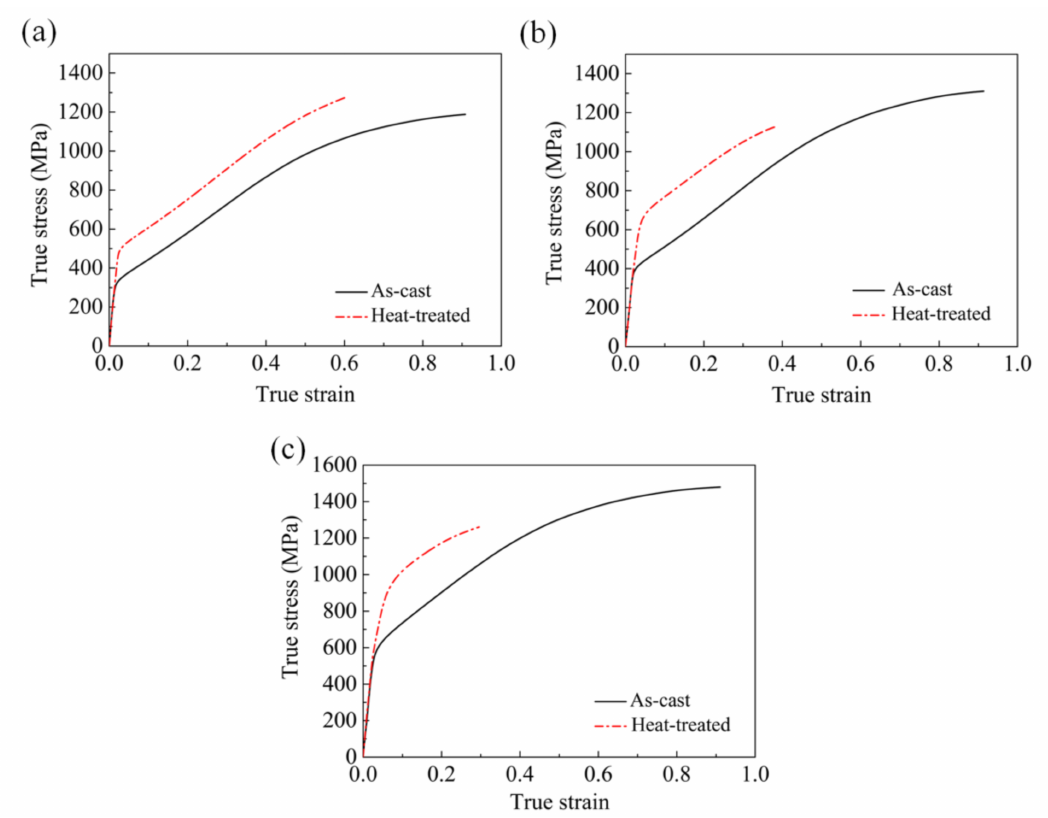
Figure 7. Influence of heat treatment on compressive stress-strain curves of nickel-based alloys: ( a ) Ni-Nb1; ( b ) Ni-Nb3; ( c )